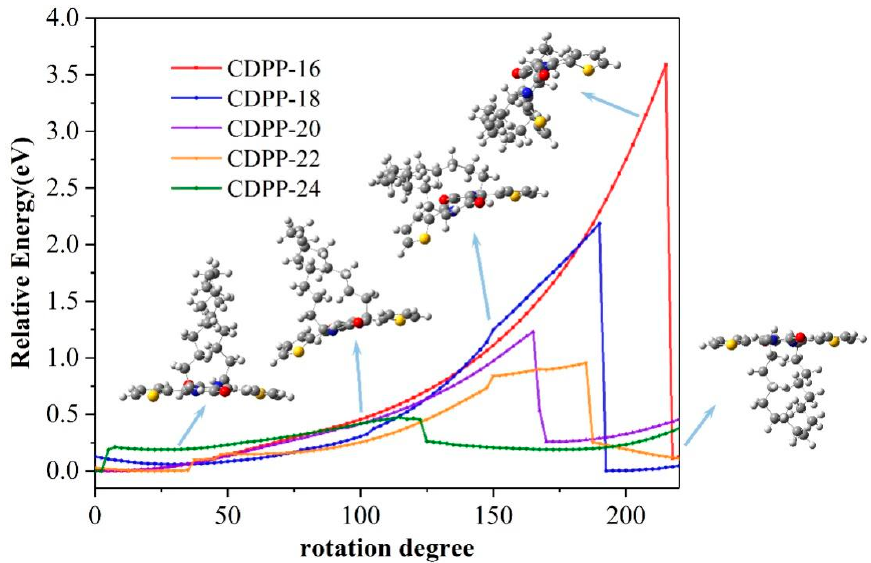
Figure 5. Geometries and relative energies during the flip of alkyl chains of ( R , R )-CDPP − 16, ( R , R )- CDPP − 18, ( R , R )-CDPP − 20, ( R , R )-CDPP − 22 and ( R , R )-CDPP − 24.